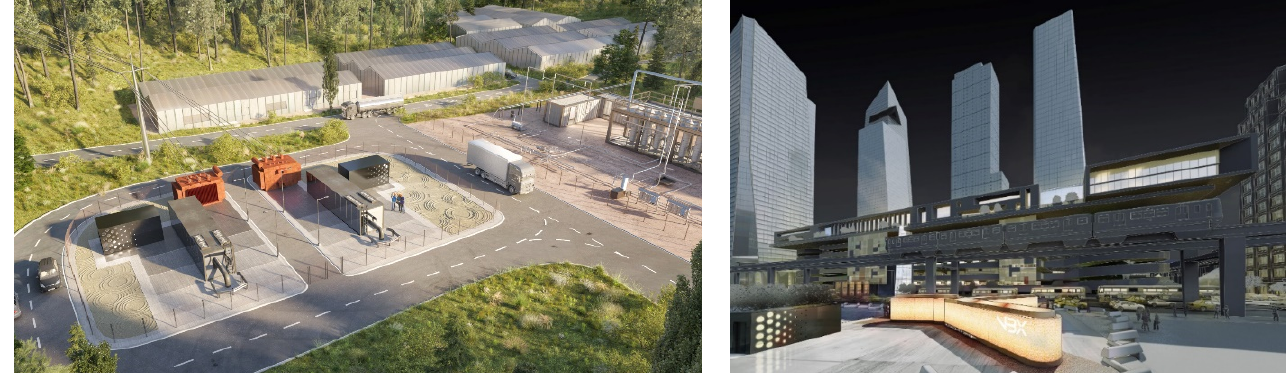
Figure 2. Examples of functional layout for ( left ) industrial and ( right ) urban NB installations. A single 10 MW NB can power some 7000–8000 homes or a large shopping mall or a mid-size data center, or produce enough desalinated fresh water for over 150,000 people.